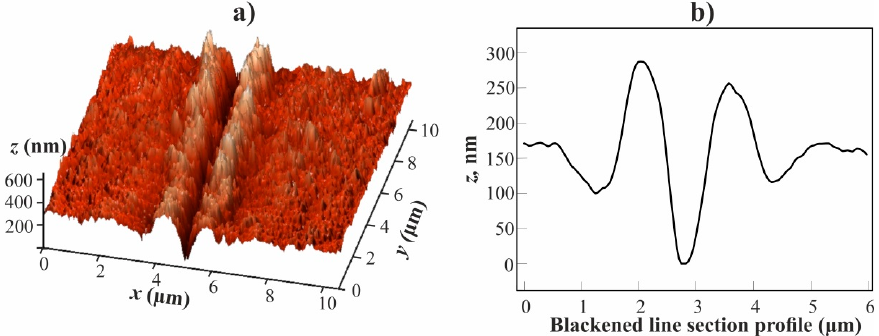
Figure 8. ( a ) Three-dimensional (3D) image of a blackened line segment obtained using AFM; and, ( b ) the blackened line section profile.